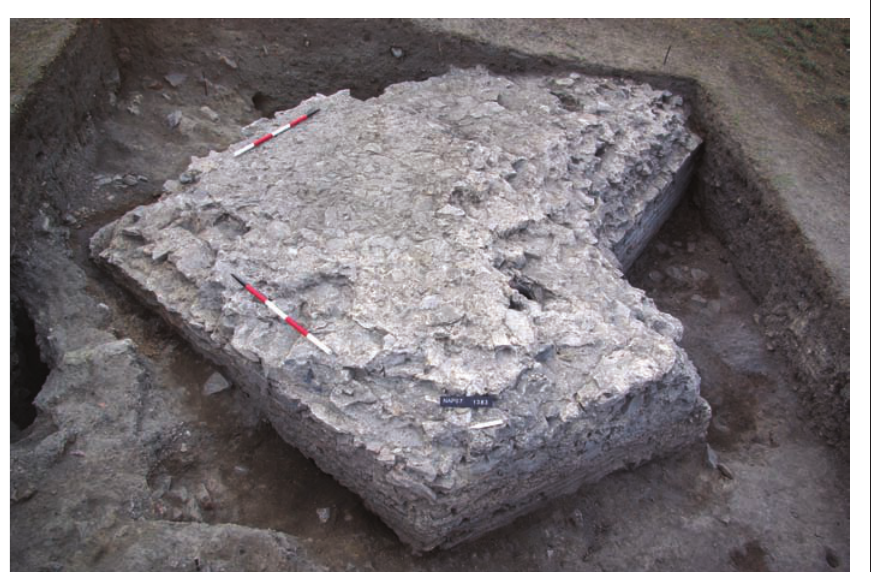
Figure 5 The entrance or tower in Area 1.7